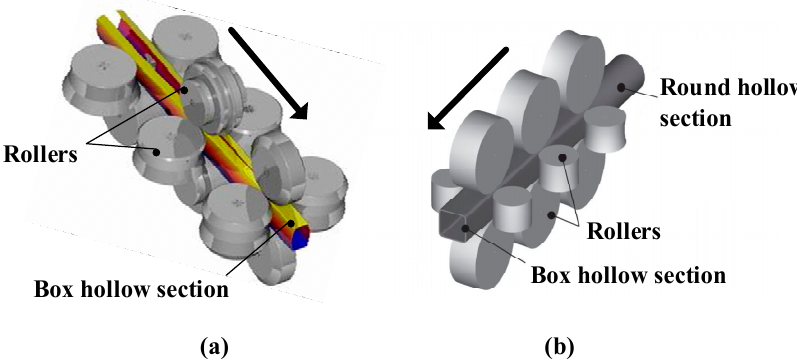
Figure 3. Two forming methods for cold-formed RHS and SHS. ( a ) Direct forming [15]; ( b ) round to square forming [16].